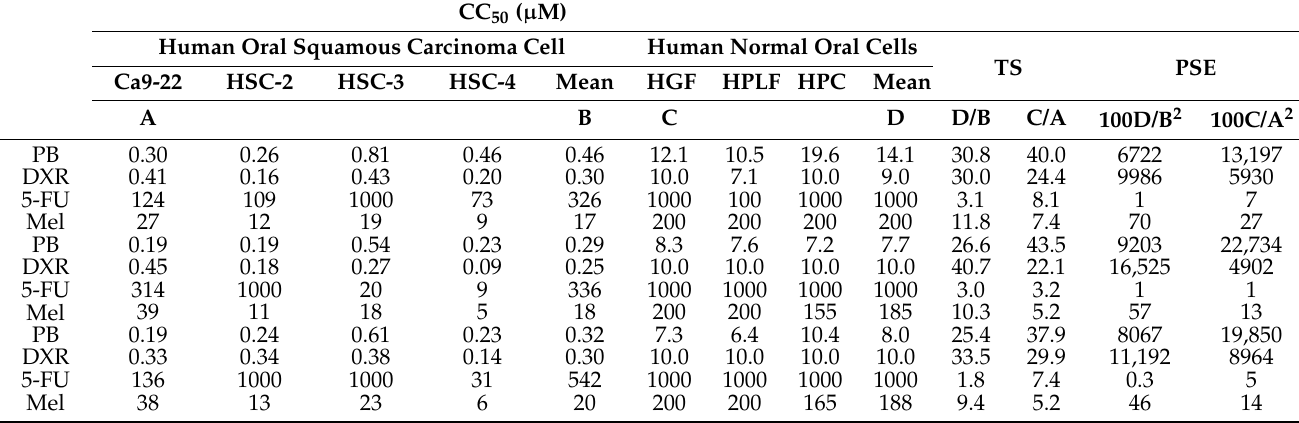
Table 1. TS and PSE values of PB and anticancer drugs, determined by three independent experiments.